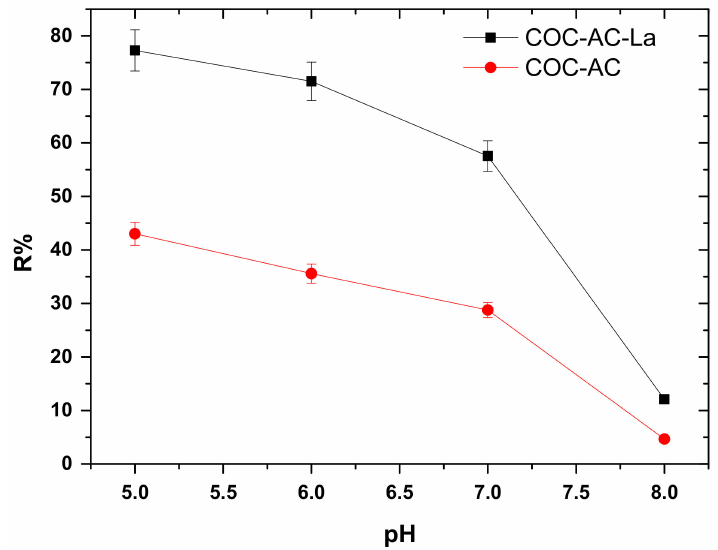
Figure 4. Effect of initial solution pH on the adsorption of Cr(VI) on COC-AC-La, in comparison with COC-AC; initial Cr(VI) concentration 100 µ g/L, dose 0.2 g/L, T = 22 ± 1 ◦ C, contact time 24 h, in deionized water.